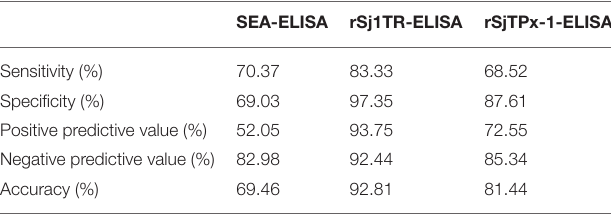
TABLE 2 | Statistical analysis of the diagnostic potentials of ELISA using SEA and recombinant antigens rSjTPx-1 and rSj1TR*.